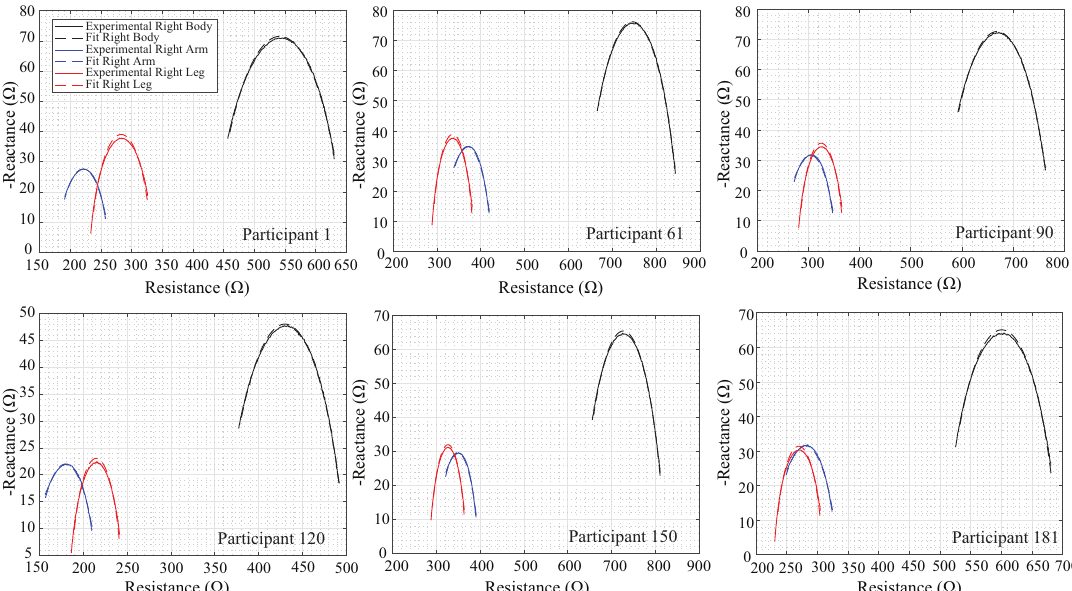
Figure 5. Samples of right-side full-body (black), right arm (blue), and right leg (red) bioimpedances collected from participants (solid line) compared to simulations of Cole-impedance model using PSO identified parameters (dashed).